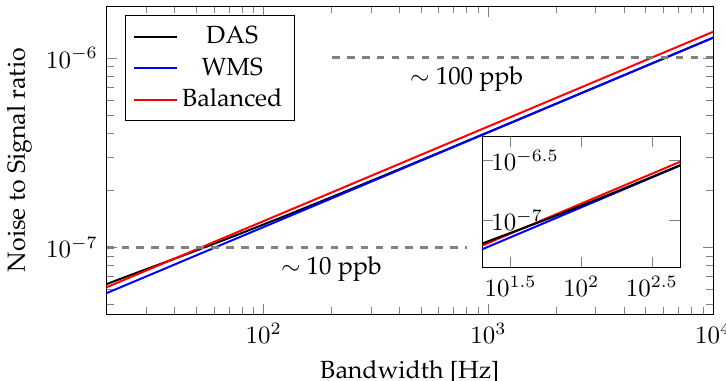
Figure 5. Relative noise levels for different bandwidths for the three investigated methods. While direct absorption spectroscopy (DAS, shown in black) has the hightest noise contributions at lower bandwidths due to the 1/f noise of the laser diode driver, it approaches the level of WMS (blue) for higher bandwidths, which compensates for this noise contribution. The balanced detection scheme (red) compensates for all the laser noise, and shows a similar trendline as wavelength modulation spectroscopy (WMS). The inset shows a zoom in of the plot and highlights, that at bandwidths of 100 Hz all the methods show a similar performance. Line markers are added to indicate the expected sensitivity levels for a SNR of unity and a propagation length of 1